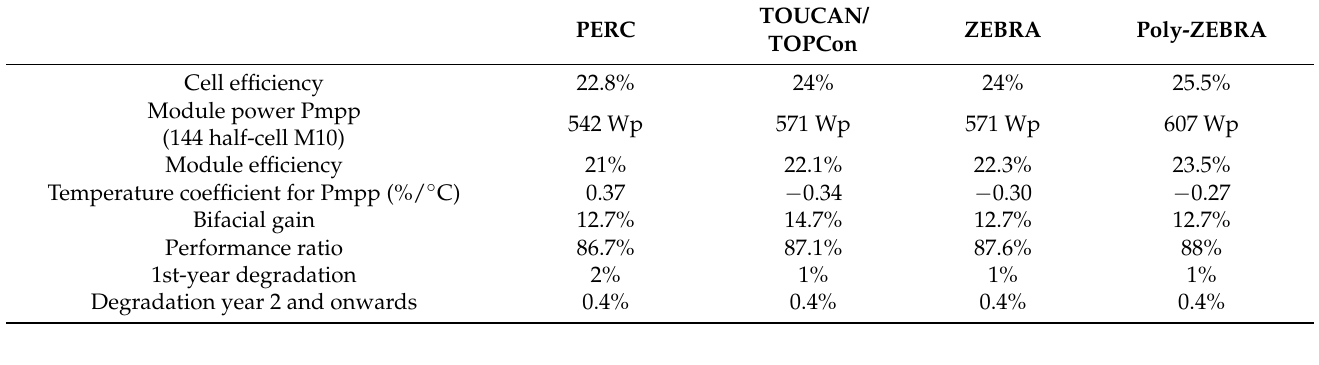
Table 6. Technology specific assumptions for LCOE.